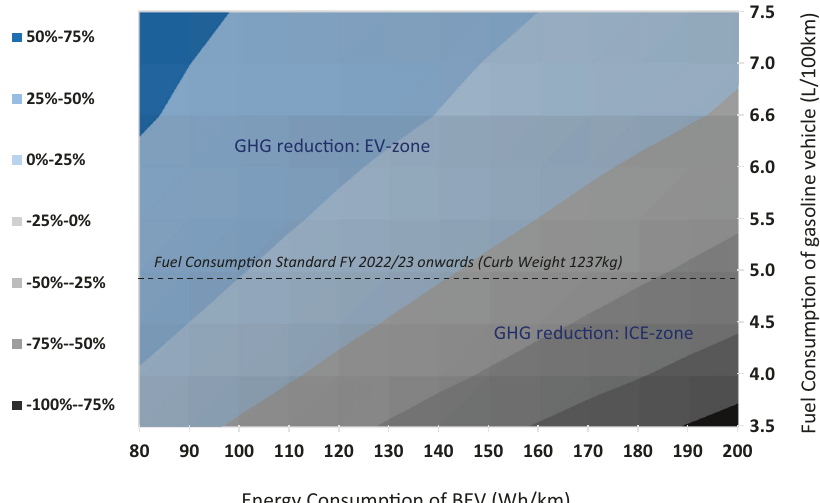
Fig. 3 Contour plot mapping the life cycle GHG emission reduction (in percentage) of battery-electric vehicles (BEVs) with a cleaner power future. The availability of cleaner electricity in 2030 can enable larger GHG reduction for BEVs. The percent GHG reduction depends on the ef fi ciency of future BEVs and the baseline gasoline vehicle in 2030. The energy generation mix in 2030 is based on the national annual average. It is assumed to be static, with additional sensitivity plots in Supplementary Fig. 15 ( b ) of the supporting document and Fig. 4 below. [EV-zone = electric vehicle (EV) results in a lower overall GHG emission; ICE-zone = internal combustion engine (ICE) results in a lower overall GHG